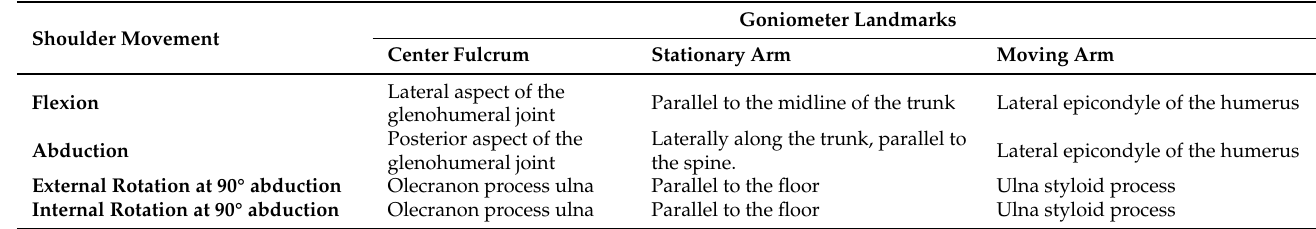
Table 1. Movement and Goniometer Landmarks.